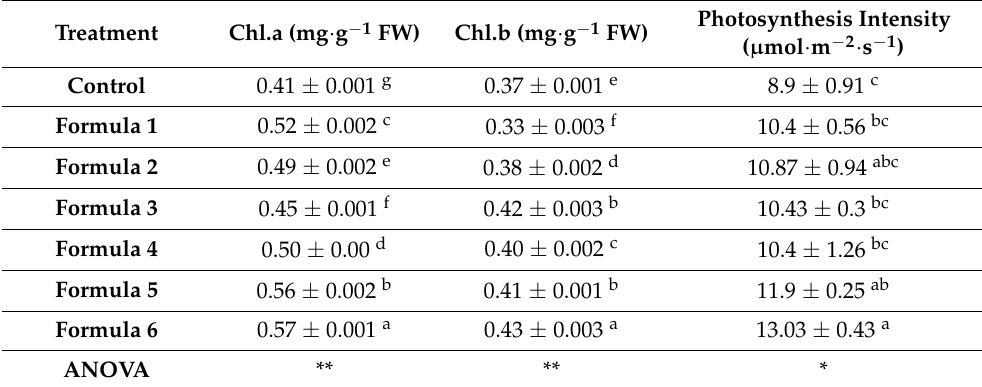
Table 6. Effects of bio-products on chlorophyll content, carotene content and photosynthesis intensity of black pepper leaves.